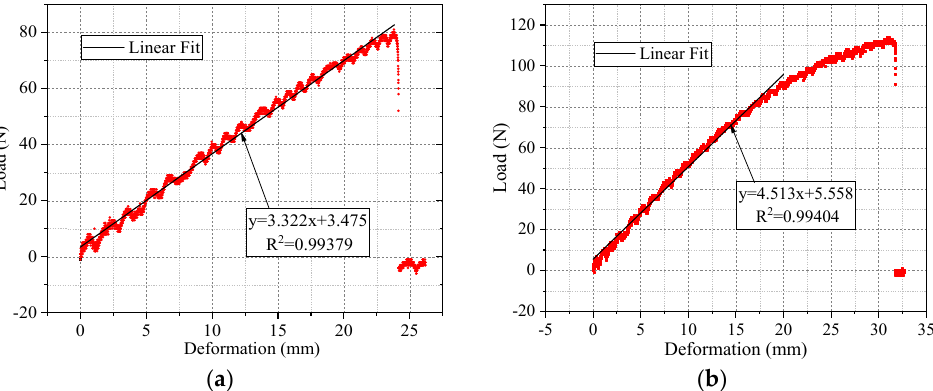
Table 5. Different tensile strengths and elongations at break under different conditions.